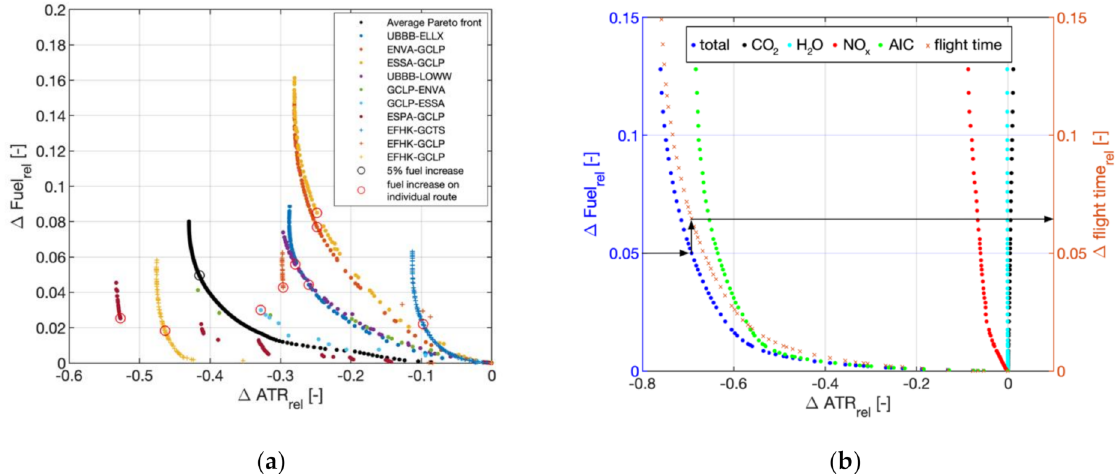
Figure 7. Top 10 single route Pareto fronts and corresponding average Pareto front ( a ) and average Pareto front ( b ) for the top 2000 routes with individual contribution of the species CO 2 (black), H 2 O (cyan), NO x (red), and contrails (green) to the overall climate impact reduction (blue) for a given fuel increase. Results are expressed relative to the minimum fuel